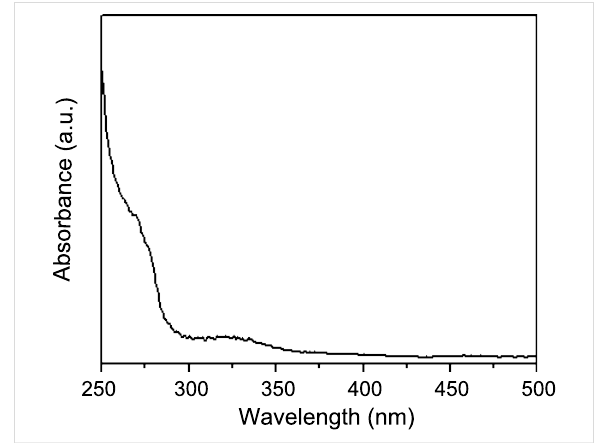
Figure 1: UV–vis spectrum of biosynthesized gadolinium oxide nano- particles solution after 96 h of reaction with the fungal biomass.